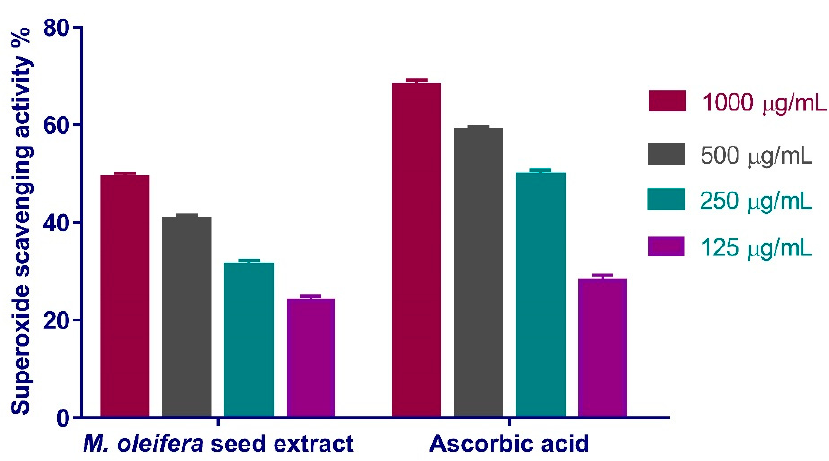
Figure 7. Superoxide radical scavenging activity of Moringa oleifera seeds extract at different concen- trations (1000, 500, 250, and 125 µ g/mL). Bars represent mean ± SD (standard deviation). Significant difference between groups is analyzed by a Two-way ANOVA test.